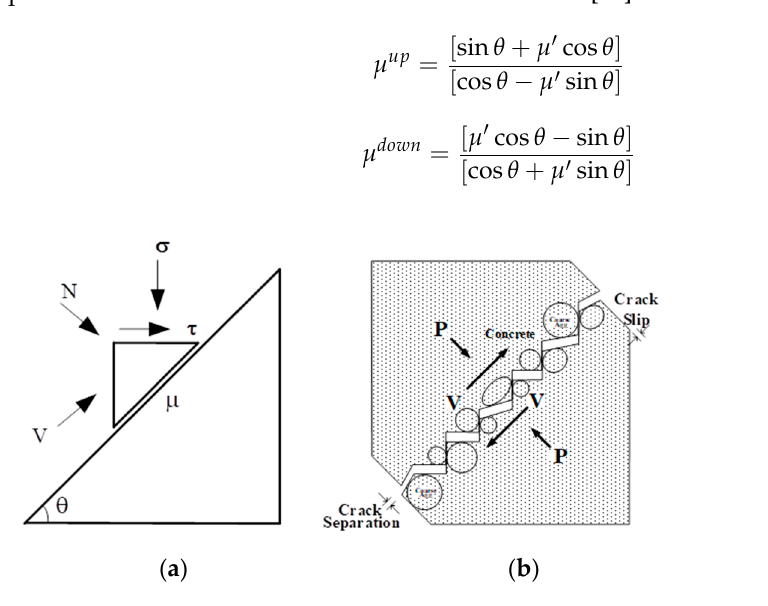
Figure 1. ( a ) Concept of crack slip mechanism and ( b ) Crack opening path